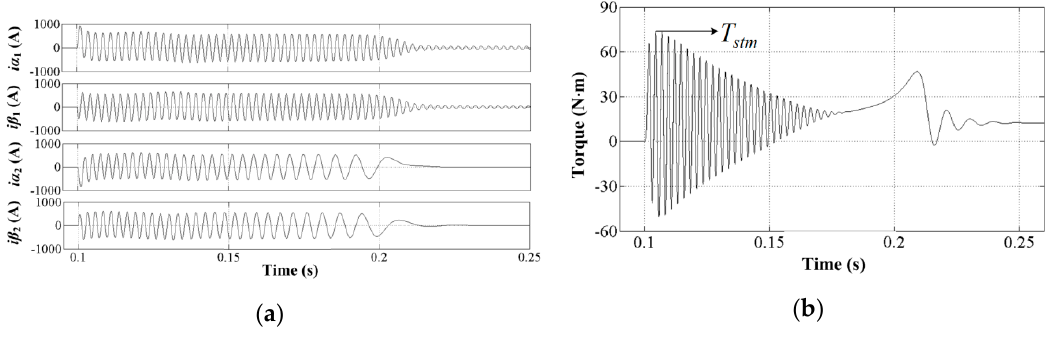
Figure 3. Current and torque of starting process. ( a ) Current waveform. ( b ) Torque waveform.